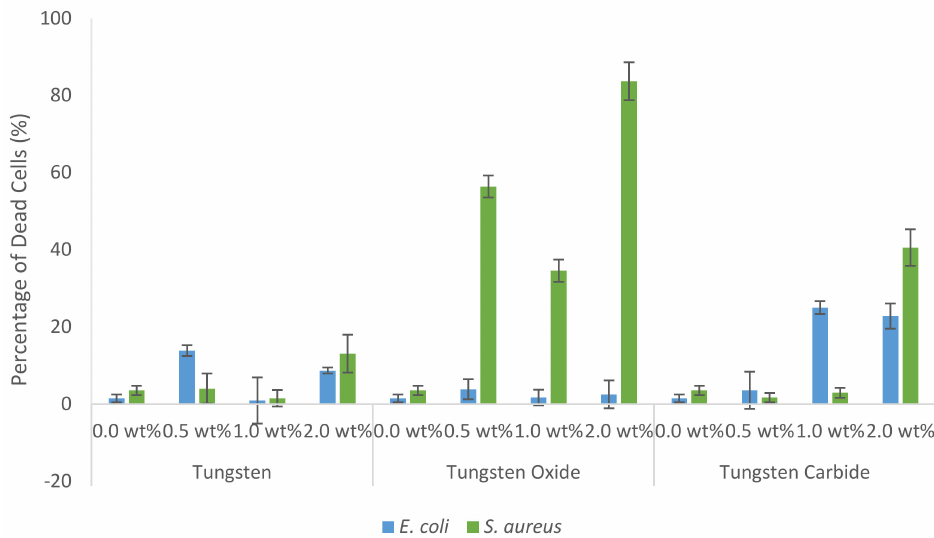
Figure 3. Graph showing the proportion of dead bacterial cells after 24 h incubation with 0.5, 1.0 and 2.0 wt % of tungsten, tungsten oxide and tungsten carbide. 0.0 wt % represents the untreated control group. Results gathered using flow cytometry in conjunction with LIVE / DEAD BacLight Bacterial Viability and Counting Kit. Error bars represent standard deviation, n =